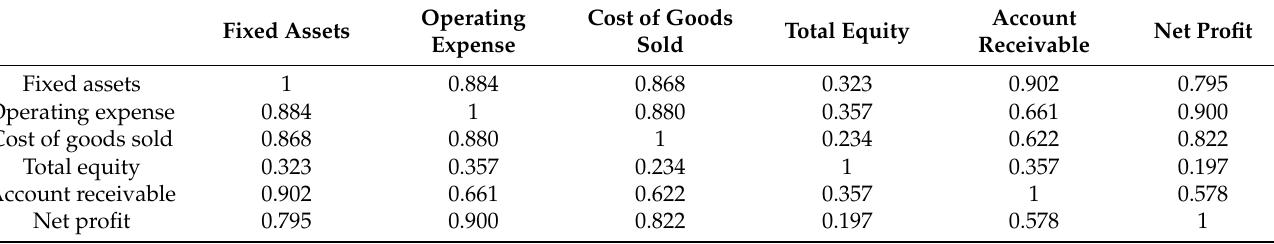
Table 7. Correlation of input and output data in 2019.